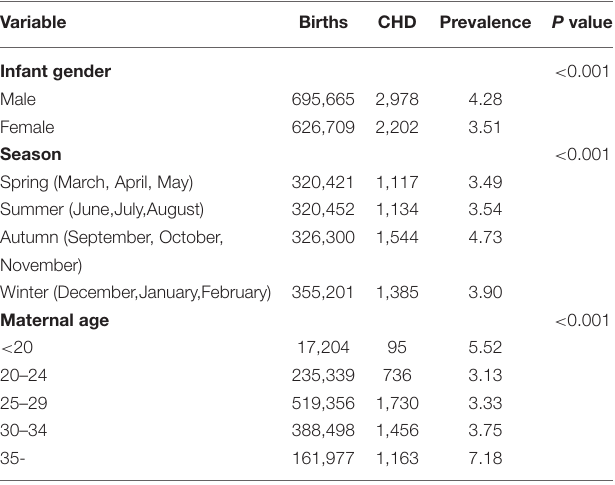
TABLE 3 | The prevalence of CHD from 2005 to 2020 in Jinan according to different characteristics. Variable